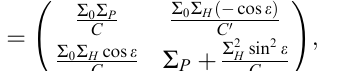
, including polarization (cid:136)